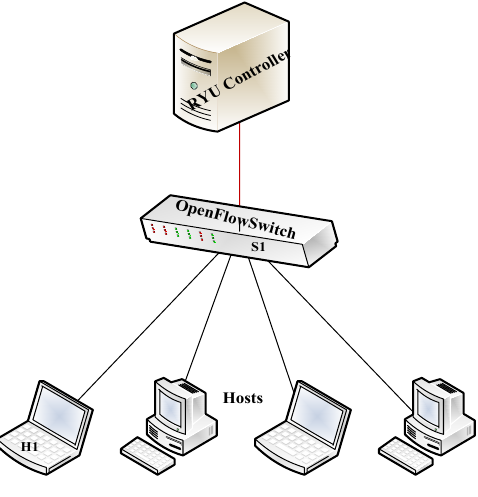
Figure 4. Single SDN Switch Scenario (4S).